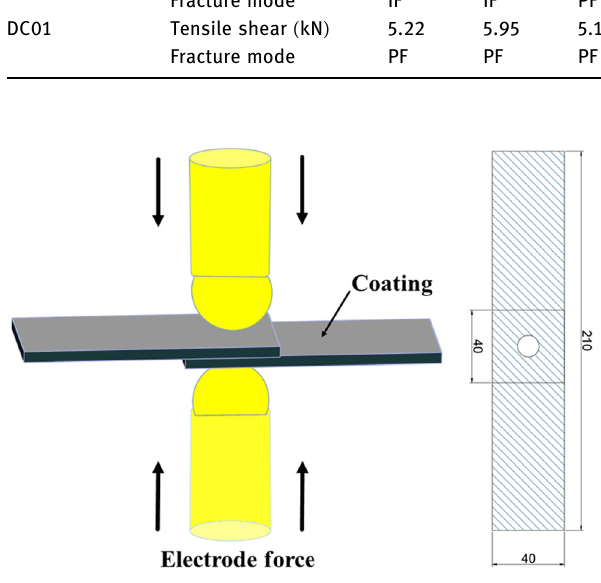
Figure 1: The schematic of welding samples.